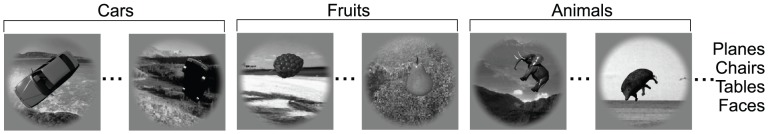
Example images used to measure object category recognition performance.Two of the 1960 tested images are shown from the categories Cars, Fruits, and Animals (we also tested the categories Planes, Chairs, Tables, and Faces). Variability within each category consisted of changes to object exemplar (e.g. 7 different types of Animals), geometric transformations due to position, scale, and rotation/pose, and changes to background (each background image is unique).